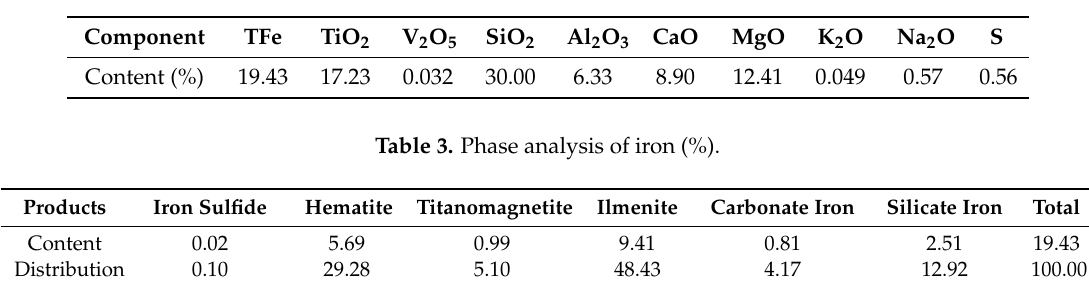
Table 2. The main chemical compositions of the studied raw ilmenite ores (TFe: total Fe).